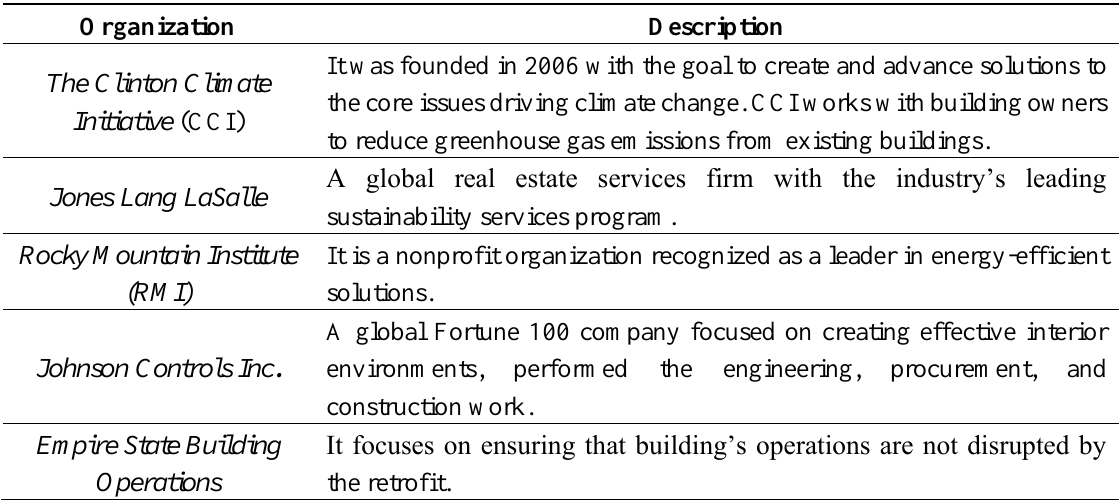
Figure 1. Fifteen-Year Net Present Value (NPV) of package vs. cumulative CO 2